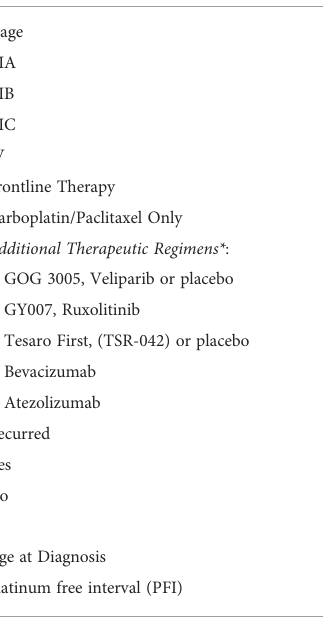
TABLE 1 Patient clinical